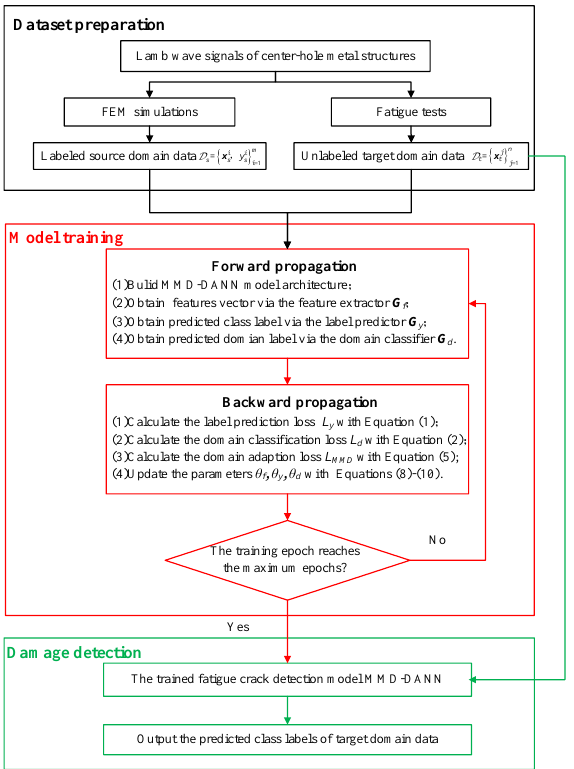
Figure 2. Flowchart of the proposed fatigue crack detection method based on MMD-DANN model. First, the Lamb wave response signals of center-hole metal structures are obtained by FEM simulations and fatigue tests. The simulated response signals under different conditions are considered as the labeled source domain data, and the experimental response signals are considered as the unlabeled target domain